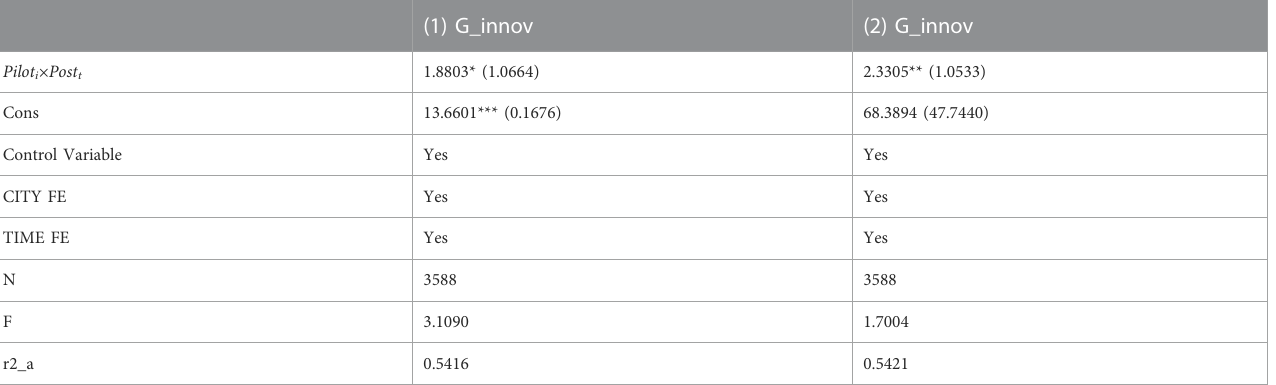
TABLE 2 Baseline regression